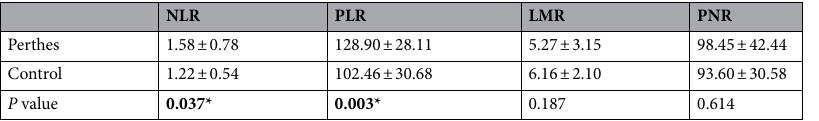
Table 4. Comparison of inflammatory indexes between LCPD in necrosis stage and control group. Significant values are in bold. *Statistically significant.